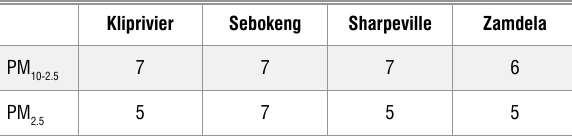
representative indicator chemical species and source profiles obtained